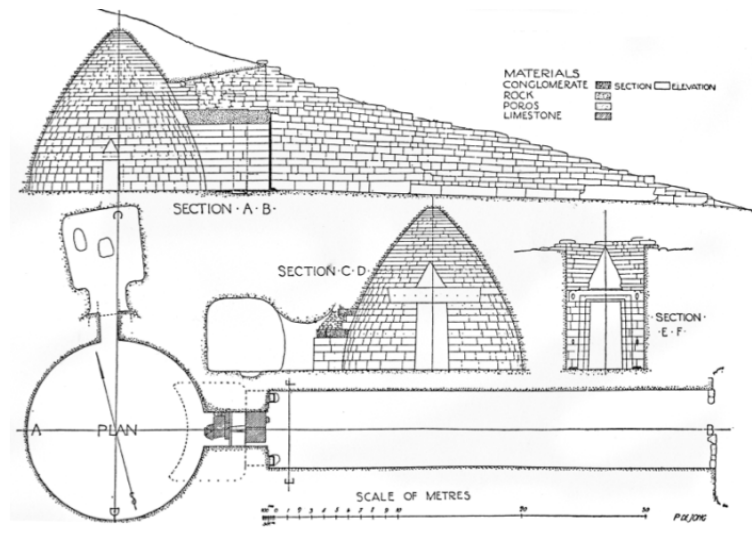
Figure 6. Schematic plan and sections of the Treasure of Atreus.